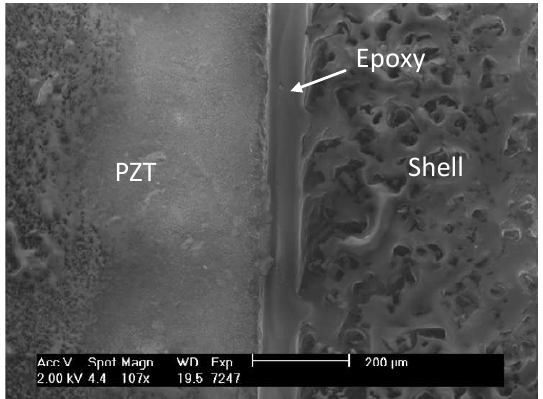
Figure 8. SEM image of the thin epoxy layer between the shell and PZT